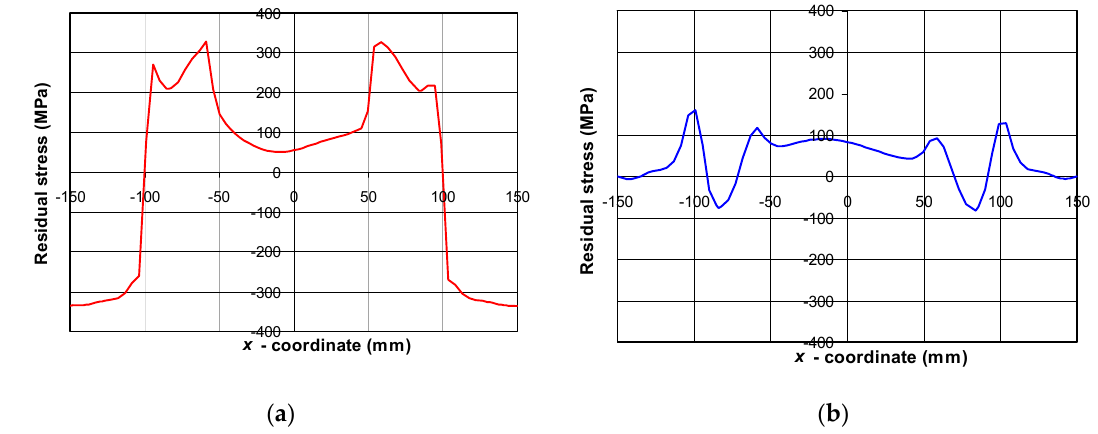
Figure 7. Residual stress field on upper model surface along line C-D (Figure 1a): ( a ) Circumferential stress; ( b ) Radial stress.